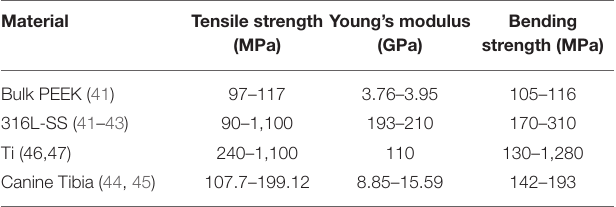
TABLE 2 | Elastic properties of bulk PEEK, stainless steel, titanium, and canine tibia obtained from the literature.